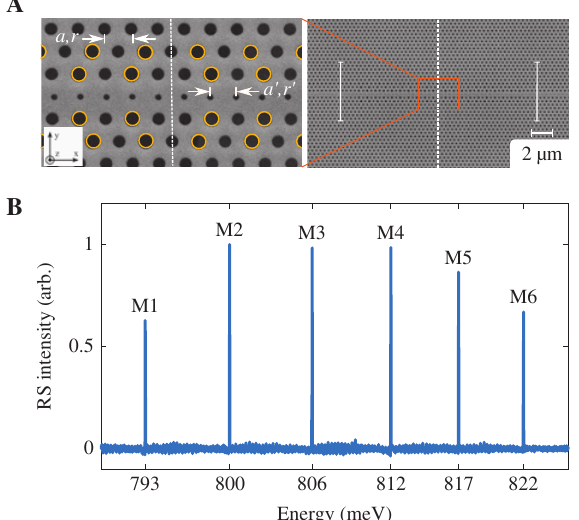
Figure 1: SEM image and layout of the bichromatic cavity and measured comb-like